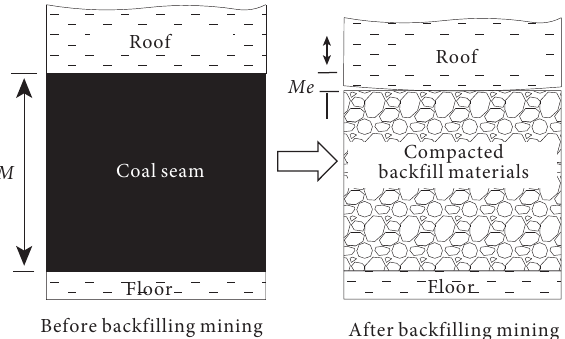
Figure 7: Diagram of the equivalent height